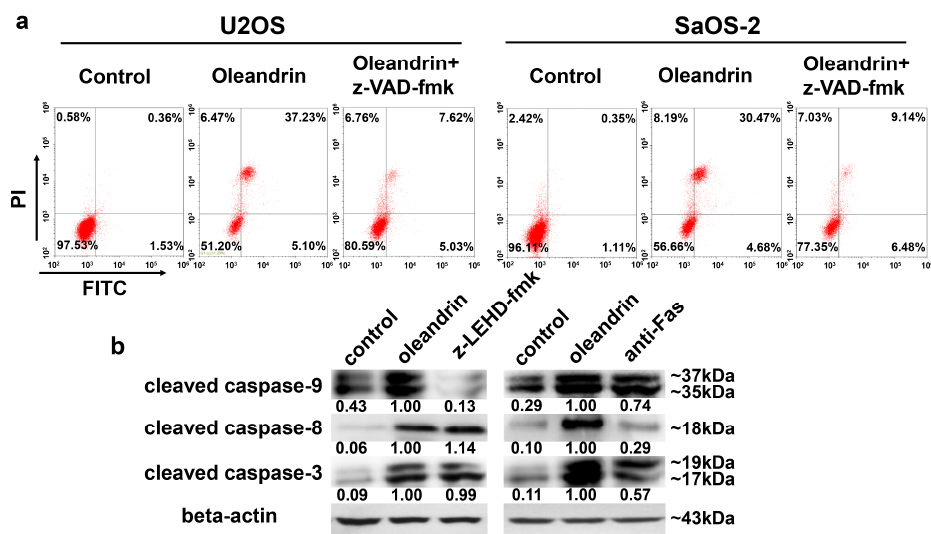
Figure 6. ( a ) Apoptosis changes of cells that pre-treated with z-VAD-fmk followed by oleandrin (50 nM) addition that detected by FCM and ( b ) Protein expression of cleaved caspase-9, cleaved caspase-8 and cleaved caspase-3 in U2OS cells detected by western blot after pre-treating